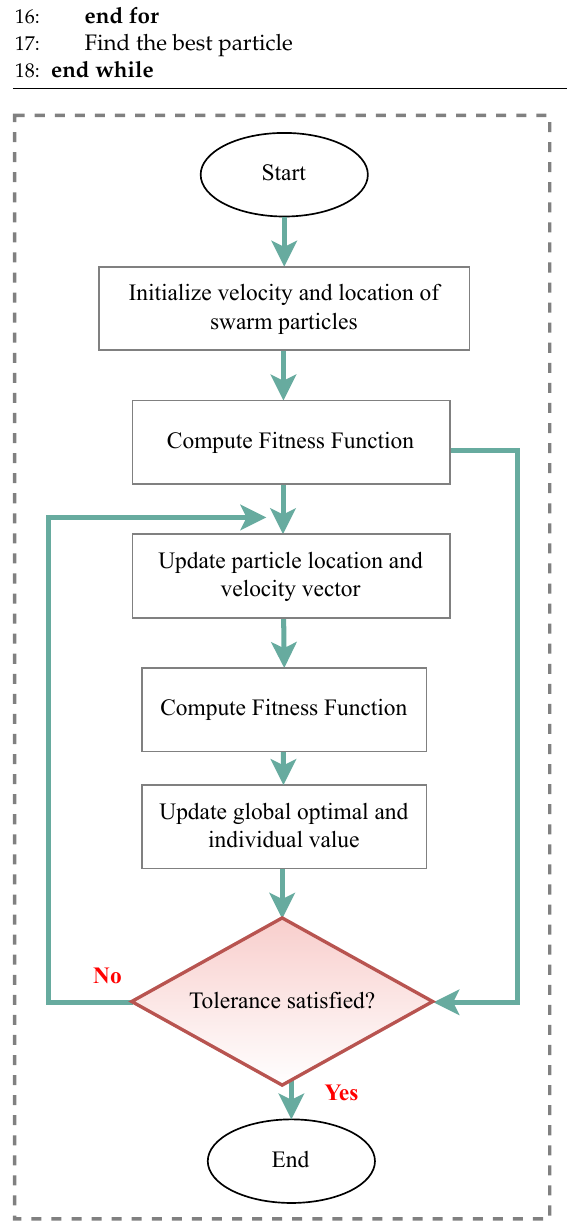
Figure 14. Flowchart of PSO